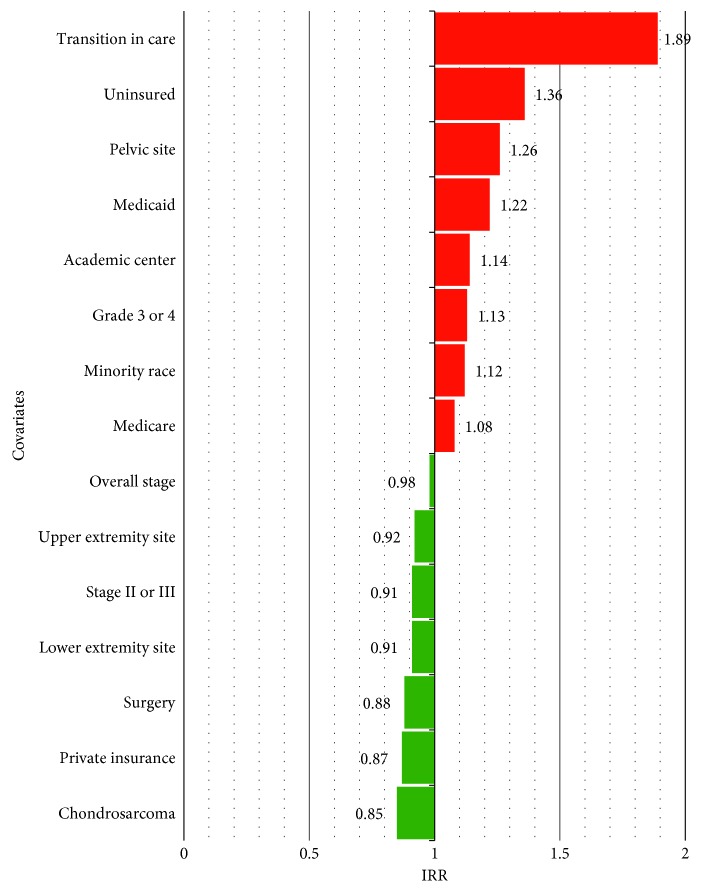
Comparison of relative association between covariates and time to treatment initiation. Only covariates with statistically significant higher (red) or lower (green) IRR are shown in this figure.